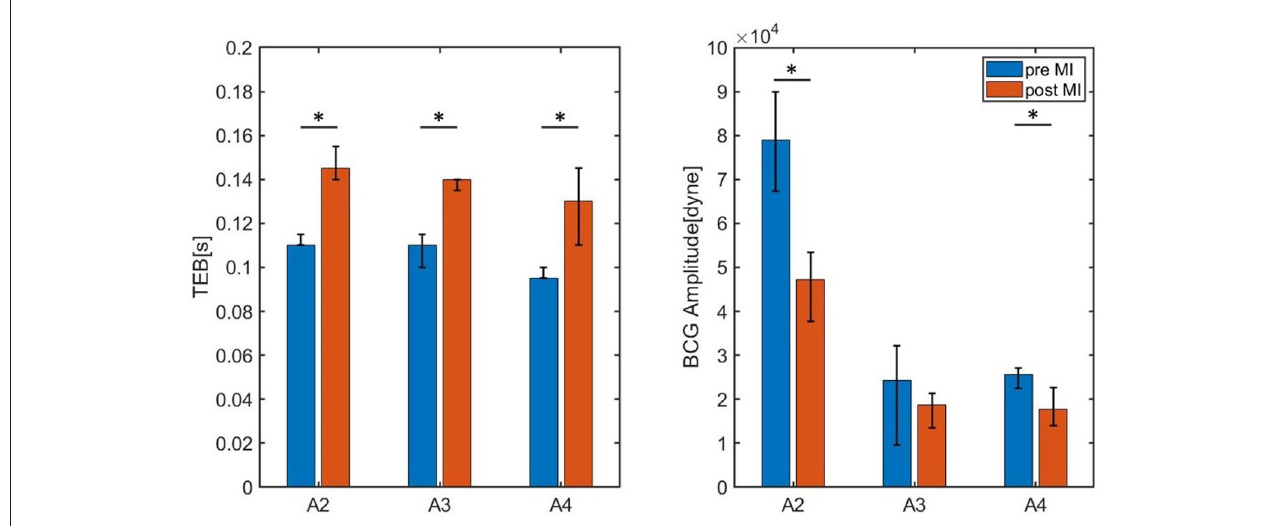
FIGURE 11 | Bar chart summarizing the values of TEB and BCG amplitude for the three swine (Subjects A2, A3, and A4) measured pre- and post-MI. The height of the bars correspond to the medians, whereas the black brackets mark the 25th and 75th percentiles. * P < 0.05 pre-MI vs. post-MI.